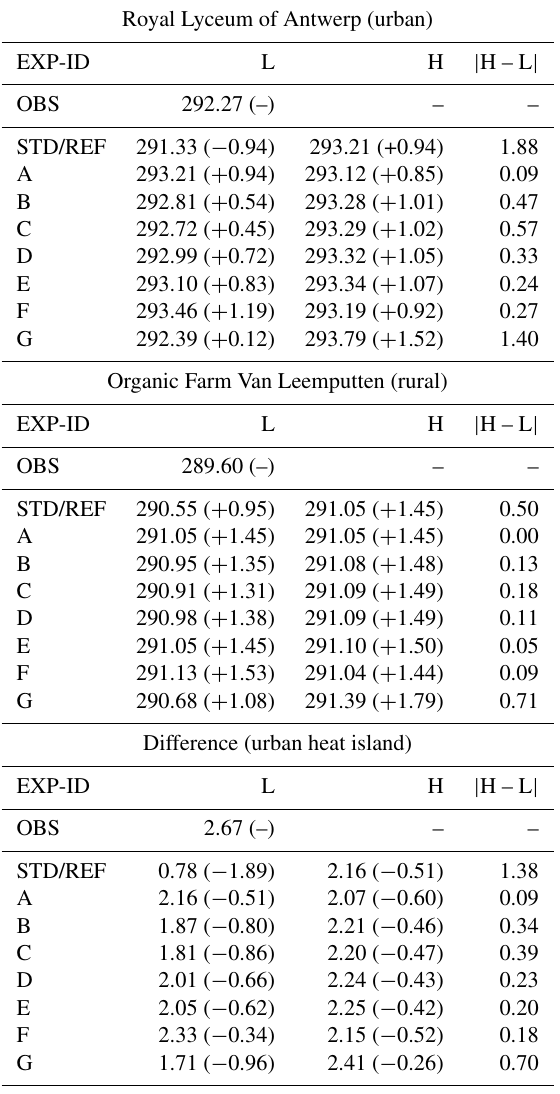
Table 4. Idem Table 3, but averaged values for the night (between 18:00 and